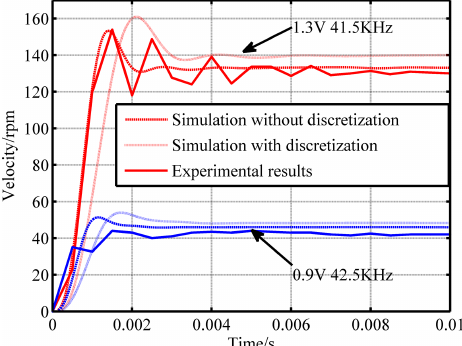
Figure 9. The transient characteristics comparing the experiment results and simulation results with or without the teeth discretiza-